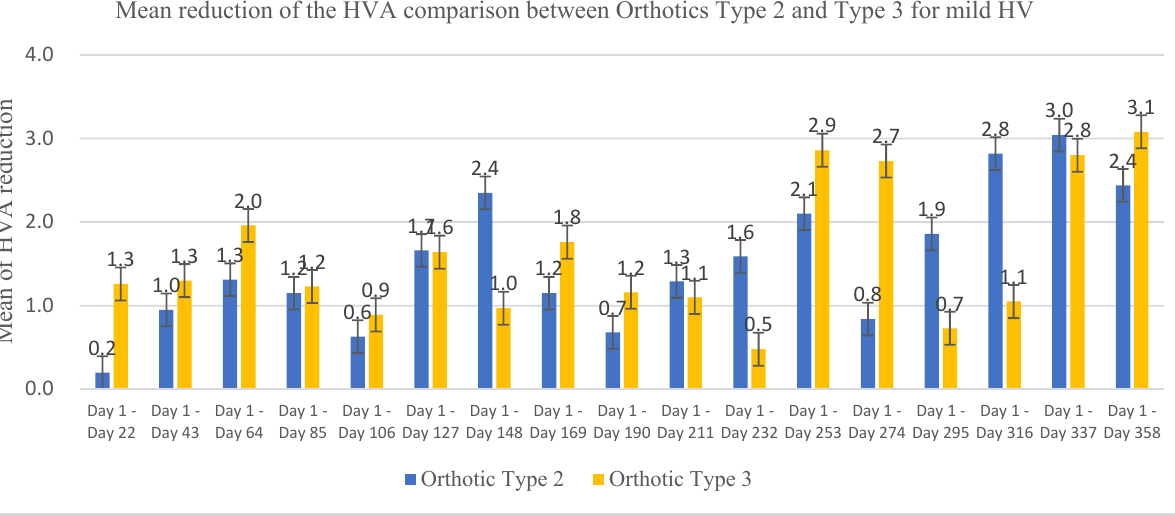
Figure 5. Mean of HVA reduction comparison between Orthotics Type 2 and Type 3 for mild HV. Table 2 shows the reduction in the patients’ mean HVA before and after treatments with three different types of orthotics. After the 12-month treatment, the Orthotic Type